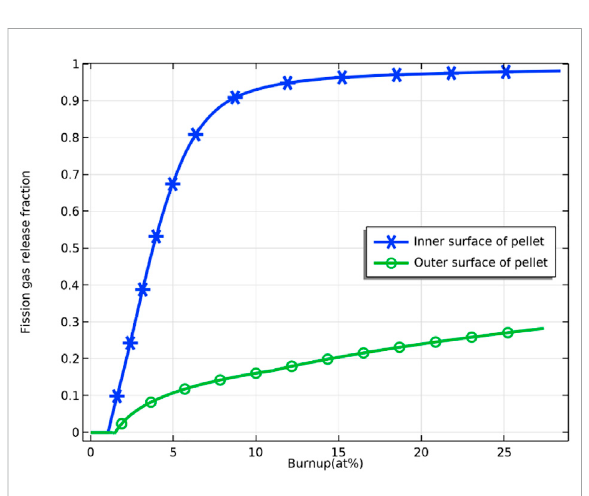
FIGURE 18 Variation of fi ssion gas release ratio on the inner and outer surfaces of fuel pellets with fuel burnup.